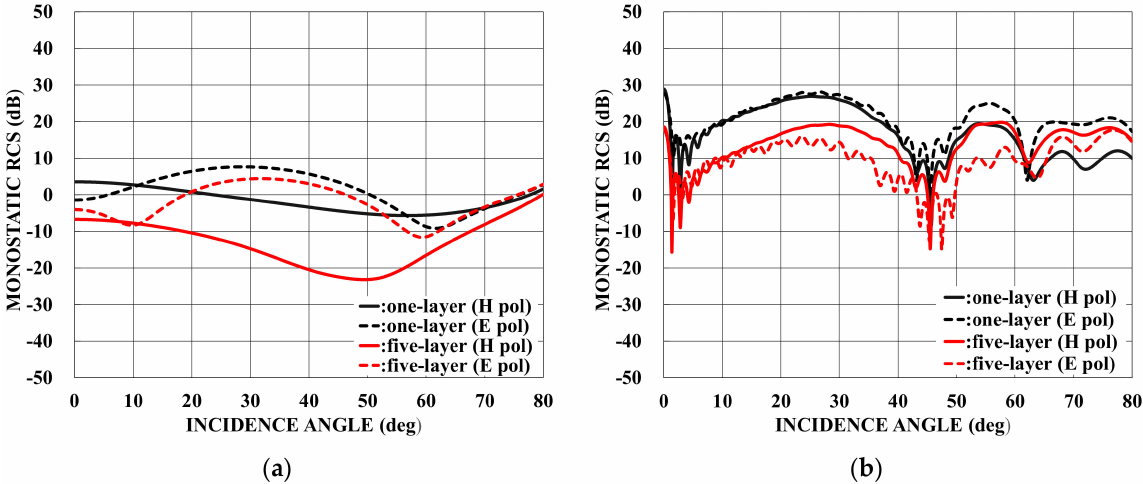
Figure 7. Comparison of the monostatic RCS [dB] versus incidence angle θ 0 between E- [46] and H-polarizations (this paper), L 1 /2 b = 1.0, kt = 1.57. ( a ) kb = 3.14. ( b ) kb = 62.8.